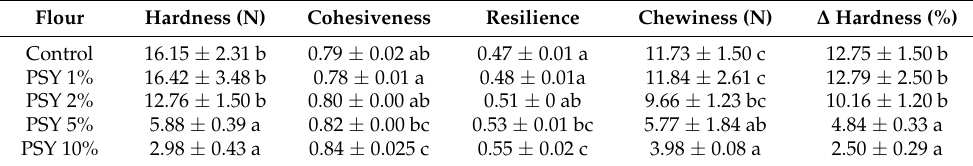
Table 2. Control and psyllium added whole bread texture properties.